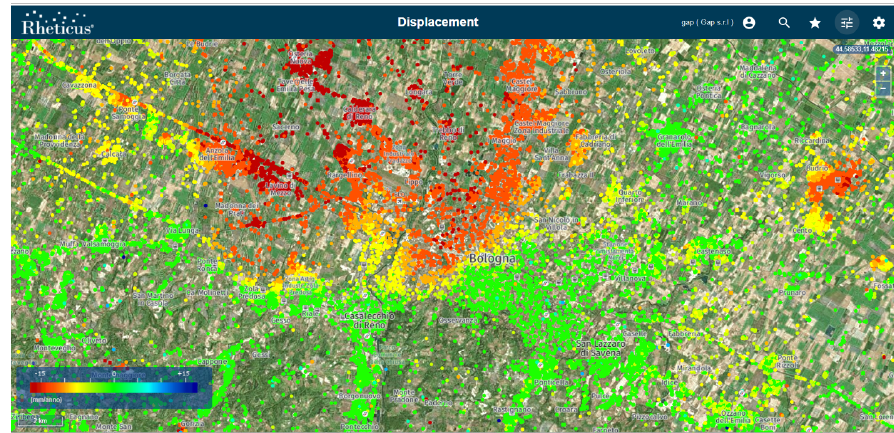
Figure A1. The displacement map obtained for the ascending